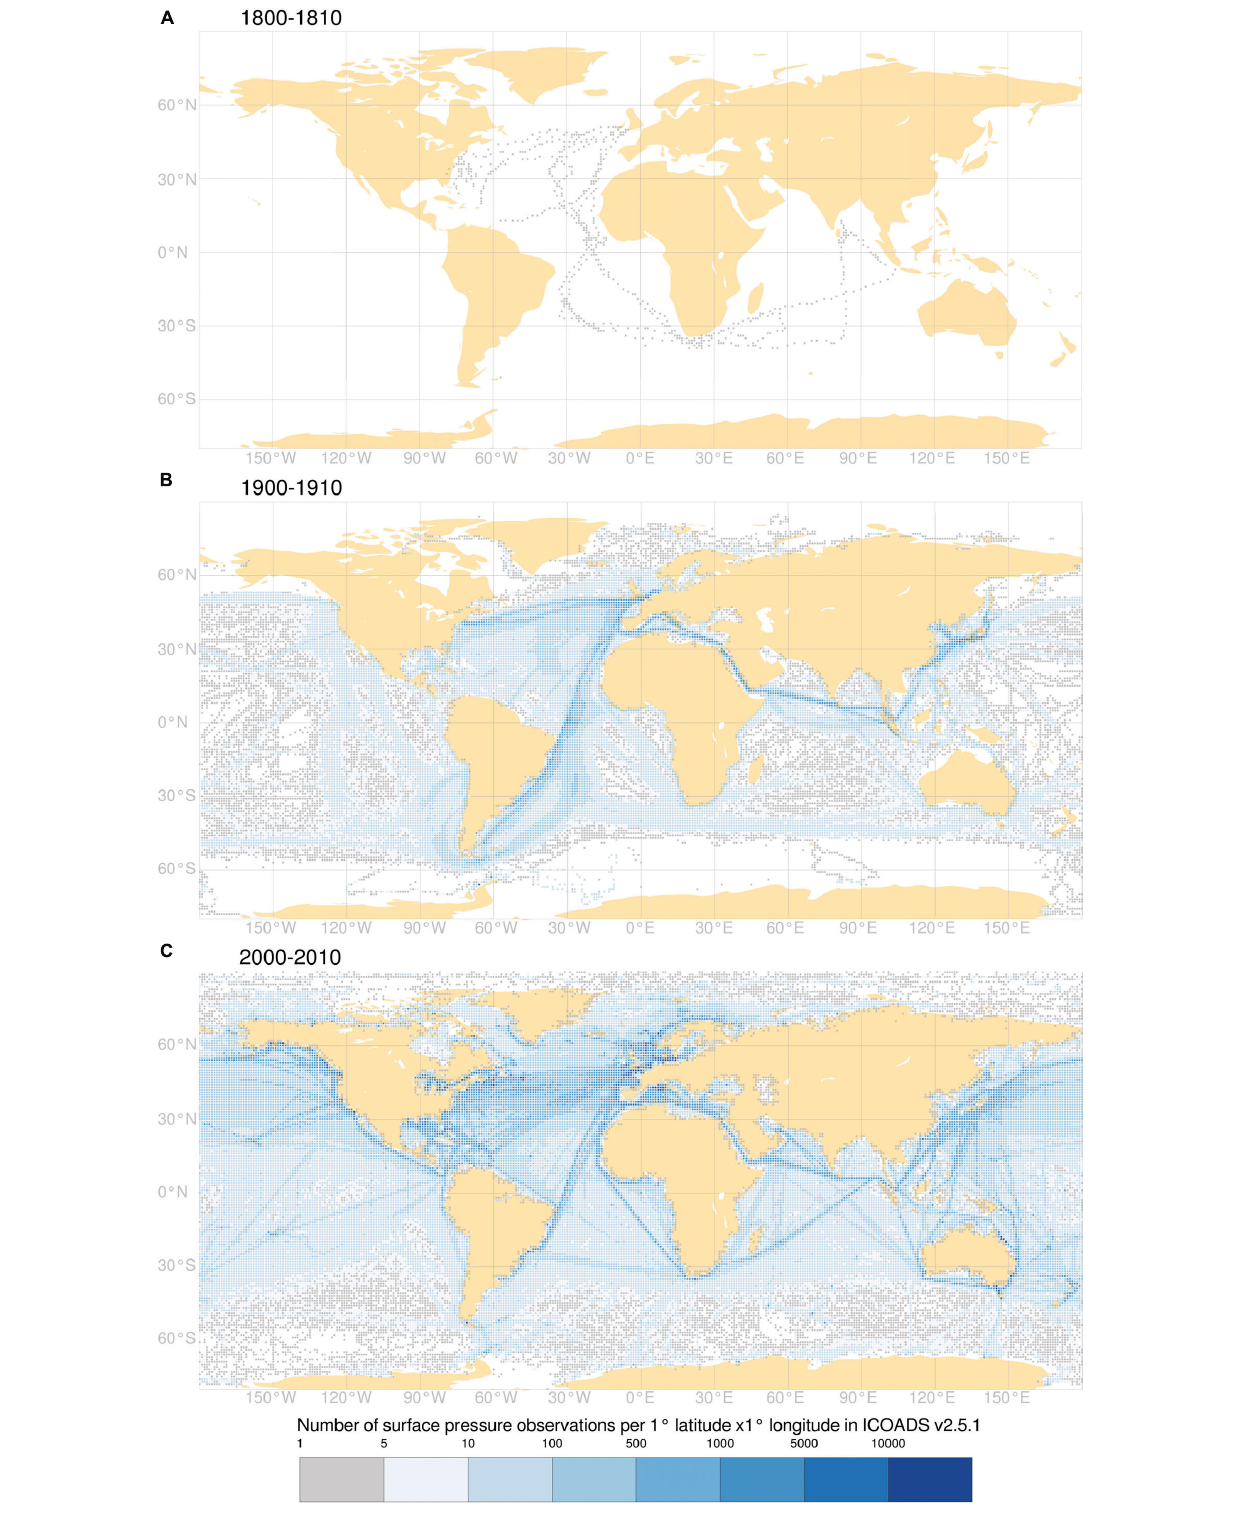
FIGURE 4 | Data counts per 1 ◦ × 1 ◦ latitude, longitude of surface pressure observations by ships in ICOADS (version 2.5.1: Woodruff et al., 2011), used by the National Oceanic and Atmospheric Administration and European Centre for Medium-Range Weather Forecasts 20th century reanalyses, for three selected time periods: (A) 1800–1810, (B) 1900–1910, and (C) 2000–2010.